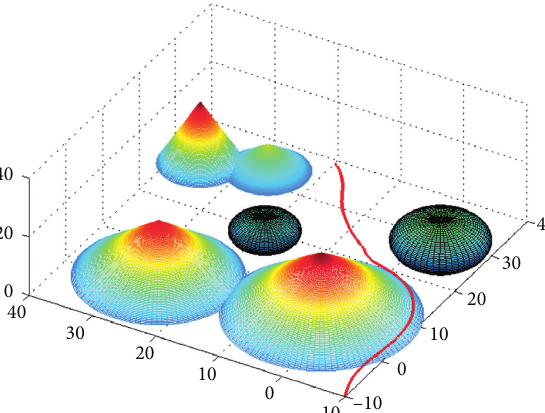
Figure 6: The planned path of the snake-shaped robot with climbing ability.